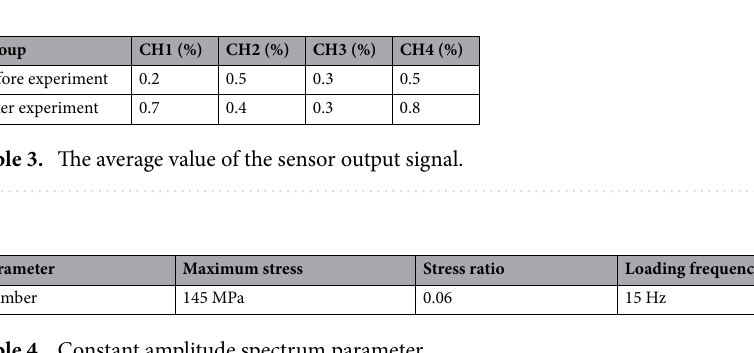
Table 4. Constant amplitude spectrum parameter.